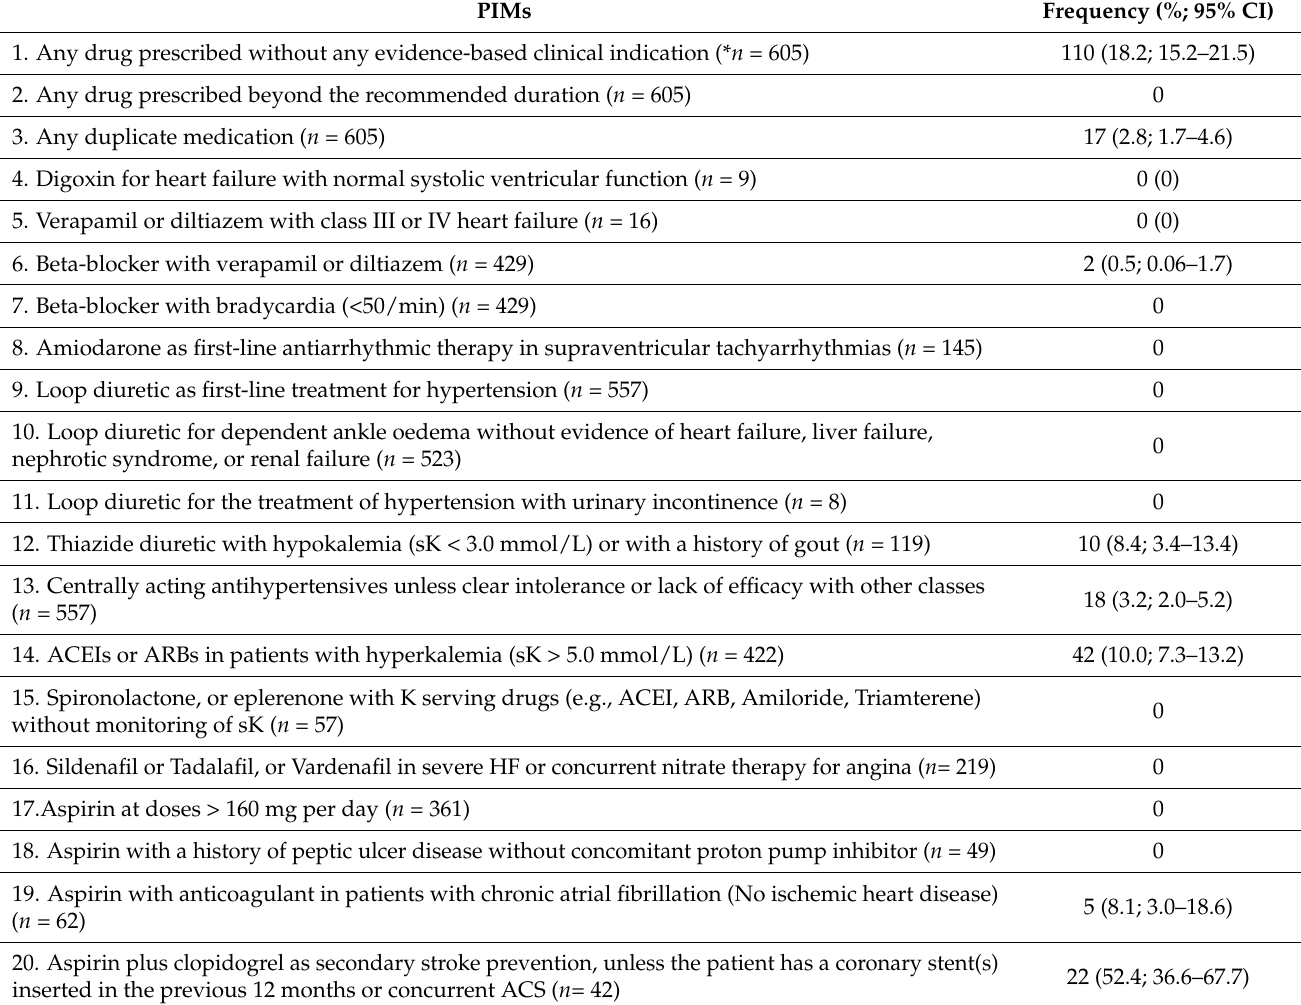
Table 3. Potentially inappropriate medications (PIMs) based on STOPP criteria among patients.